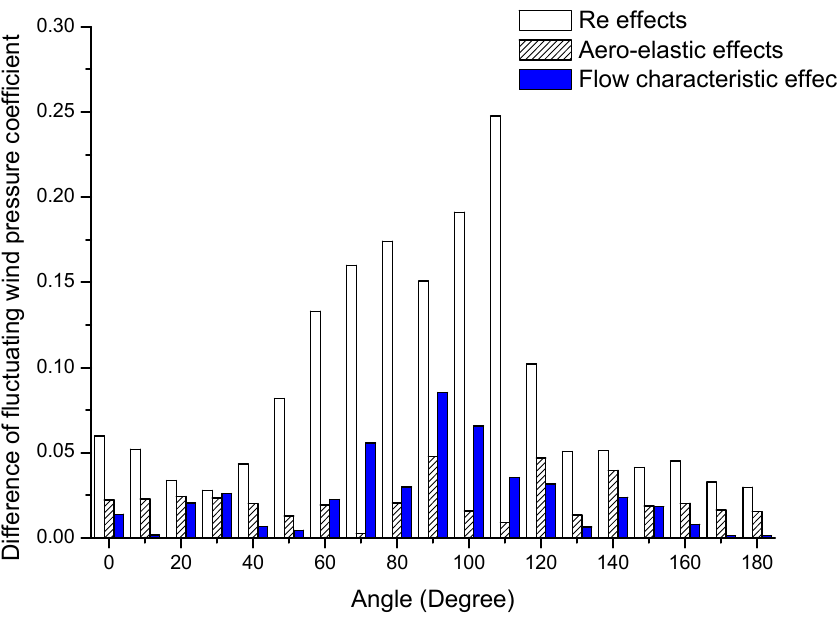
Figure 14. Comparison of the three adverse effects for fluctuating wind pressure coefficients. Table 2. The three adverse effects in relative